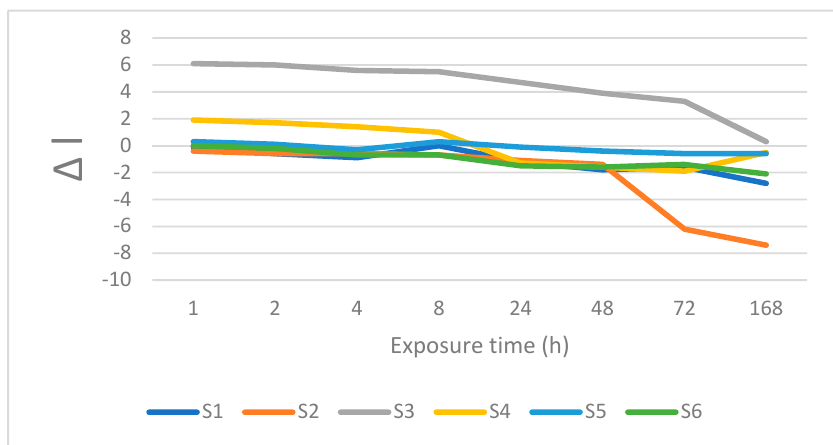
Figure 3. Changes is lightness after immersion in tea.